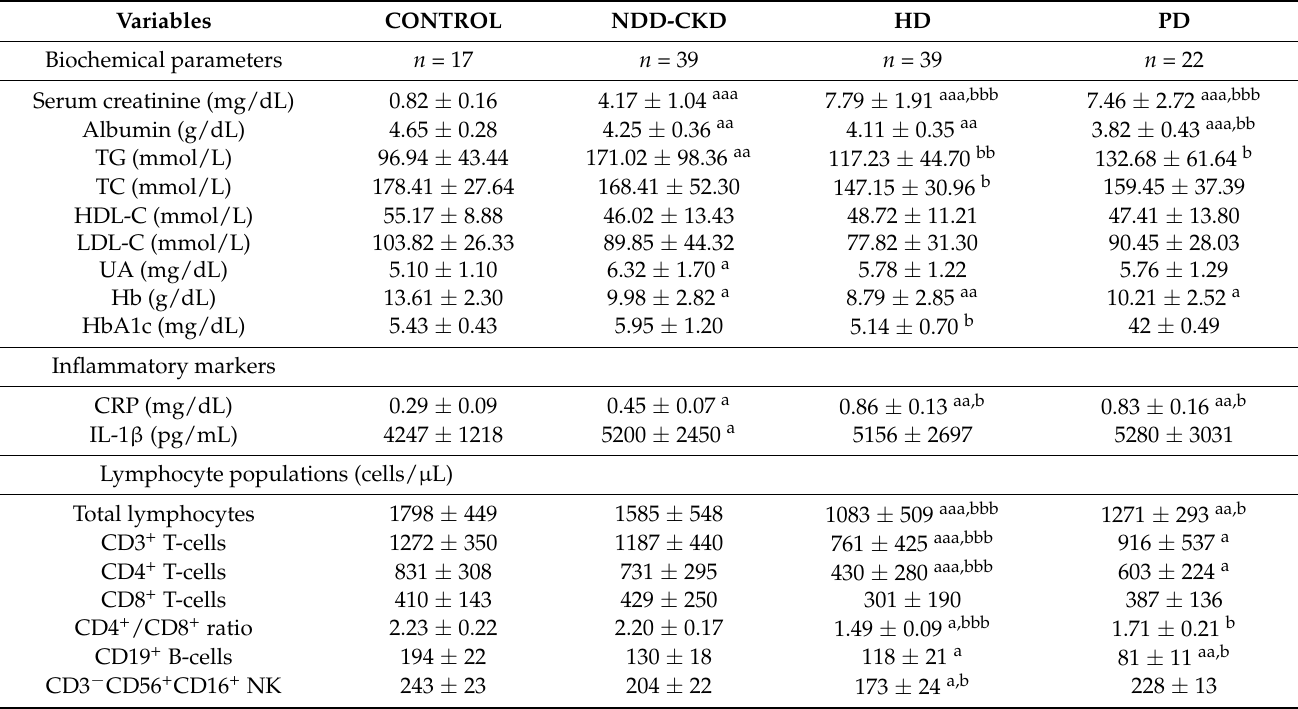
Table 2. Biochemical and inflammatory parameters and lymphocytes population of the study participants. Variables CONTROL Biochemical